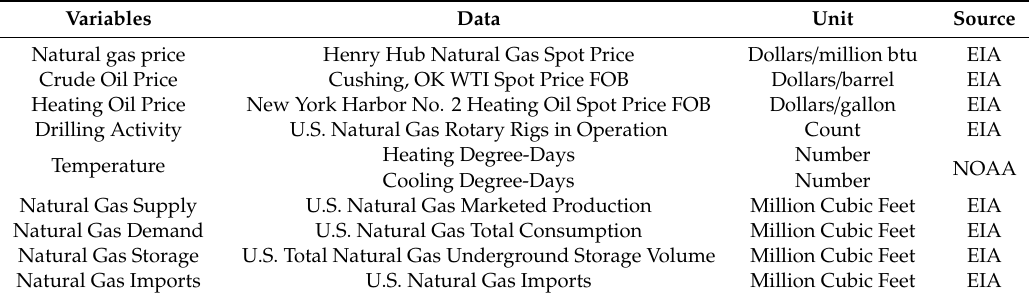
Table 1. A list of the variable used in this study.